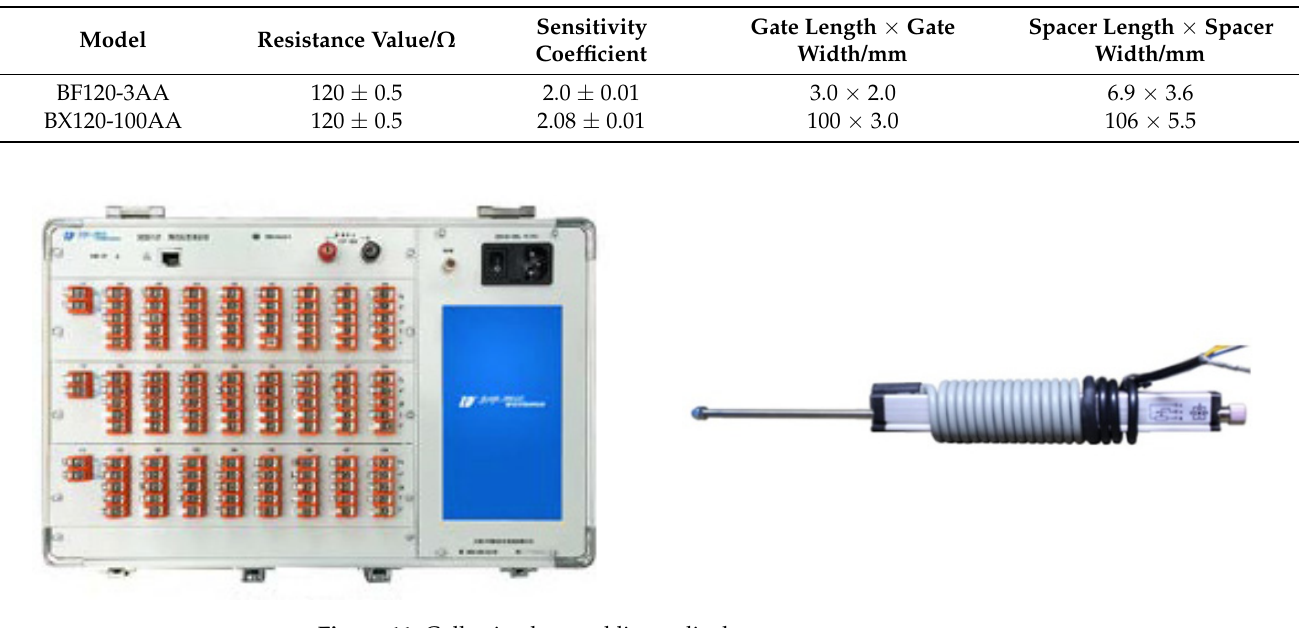
Figure 11. Collection box and linear displacement